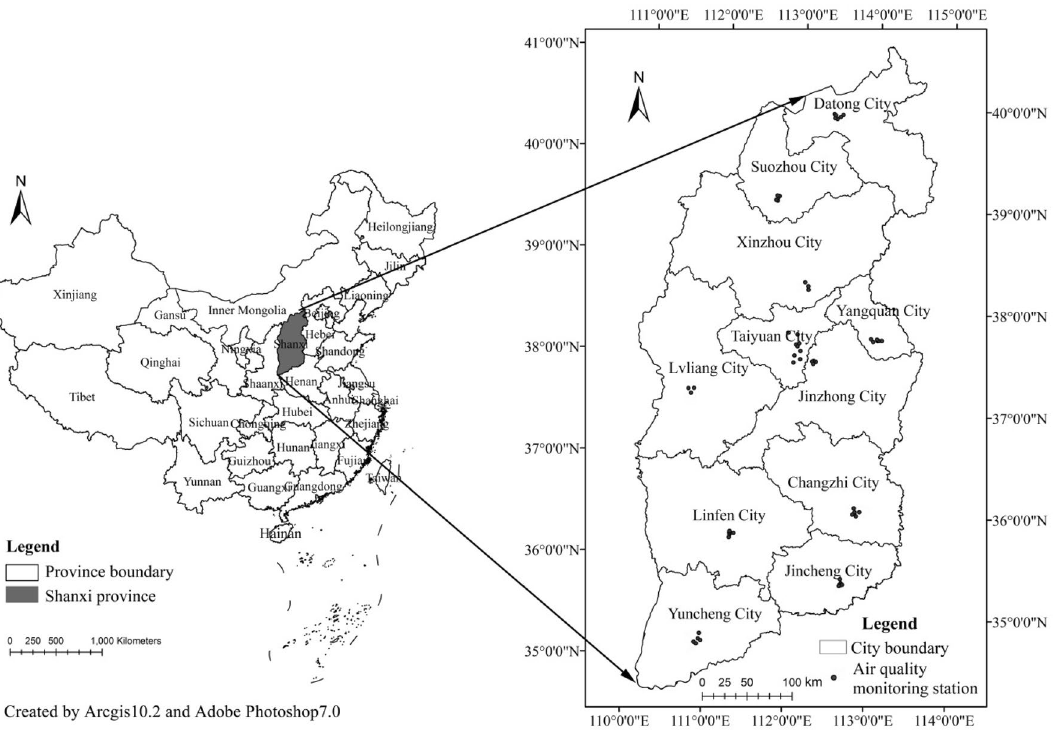
Figure 1. The location of Shanxi Province in China and the location of air quality monitoring stations in Shanxi